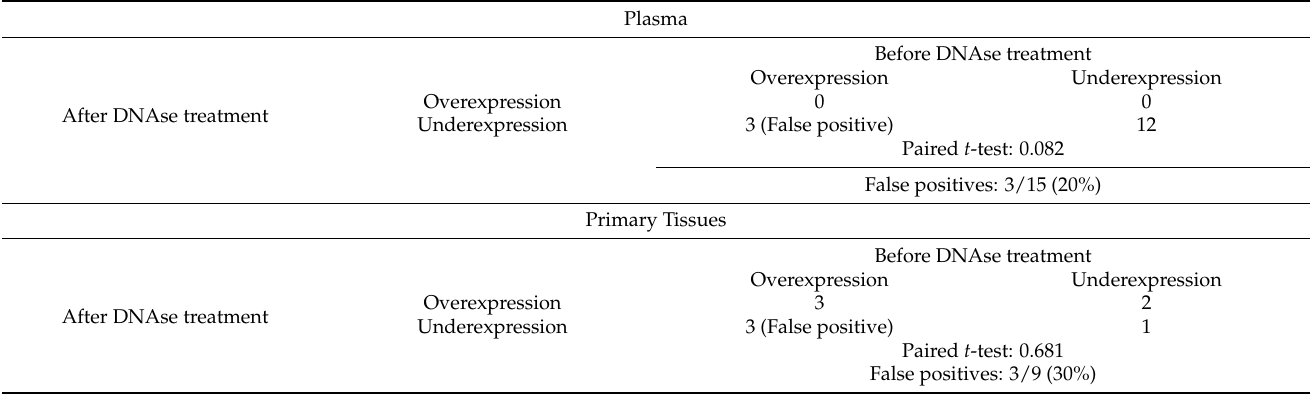
Table 3. MALAT1 expression in plasma ( n = 15) and tissue samples ( n = 9 pairs) of NSCLC patients before and after DNase